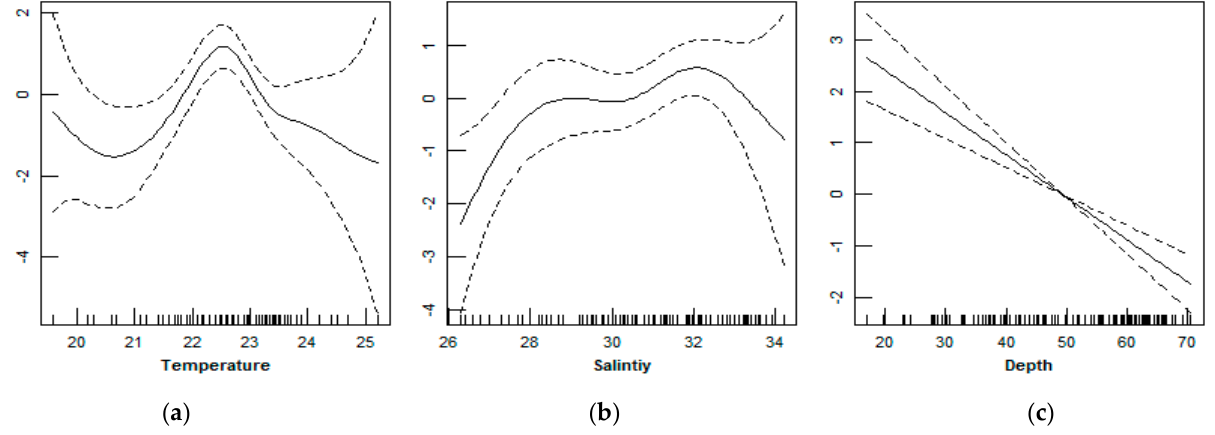
Figure 2. Relationship between the density of D. maruadsi and environmental factors in coastal waters of southern Zhejiang at seasonal scales (Spring): ( a ) effect of temperature; ( b ) effect of salinity and ( c ) effect of depth. Dashed lines show 95% confidence